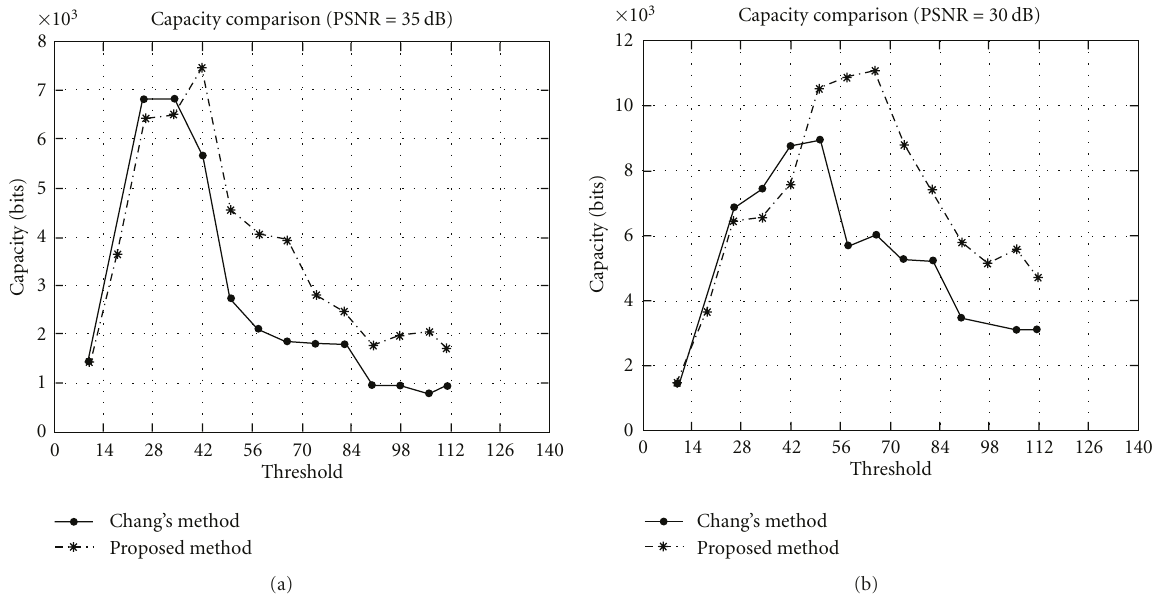
Figure 11: Embedding capacity comparison between the PEC and CW algorithm when applied to Figure 9 with the threshold PSNR set to (a) 35 dB and (b)